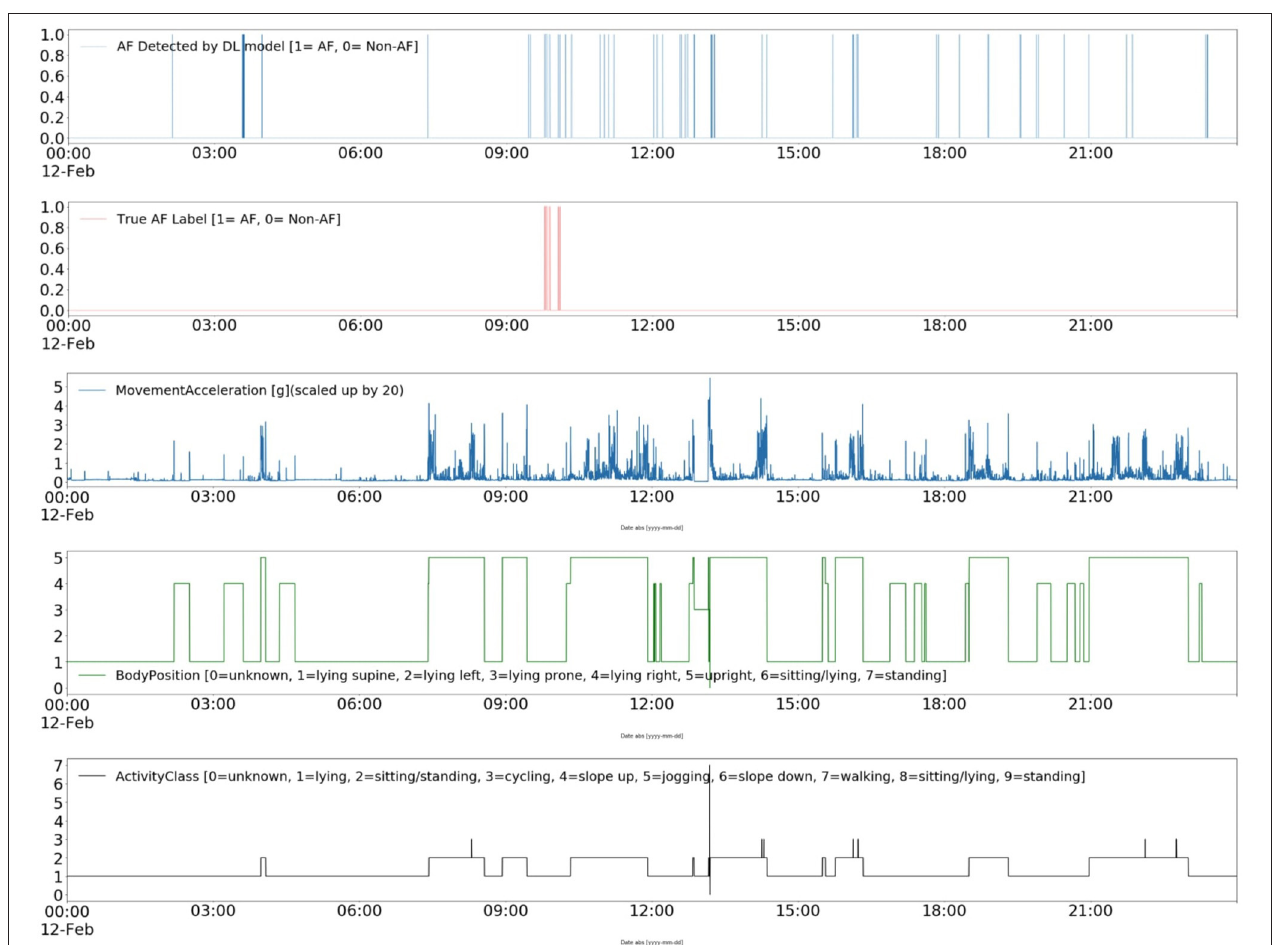
FIGURE 7 | Explainable deep learning: This Figure shows a contextualized view of a deep learning-based AF detection model Andersen’s (25) performance on a single day of ECG from CACHET-CADB. In 24 h of ECG under free-living conditions, short segments of false positive in a model’s output are linked to change in activity, change in body position, and sudden movement